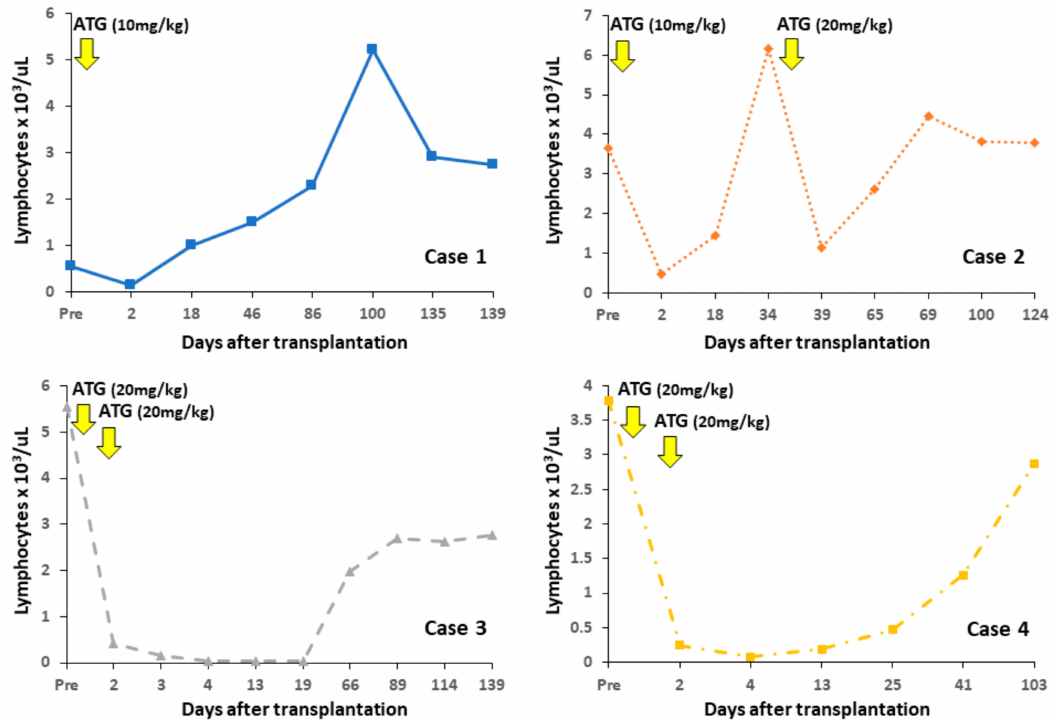
Figure 6. Changes in peripheral lymphocyte counts. Lymphocyte counts decreased after administration of antithymocyte globulin (ATG). The nadir lymphocyte counts in cases 3 and 4 were prolonged by di ff erences in ATG doses, in comparison with counts in cases 1 and